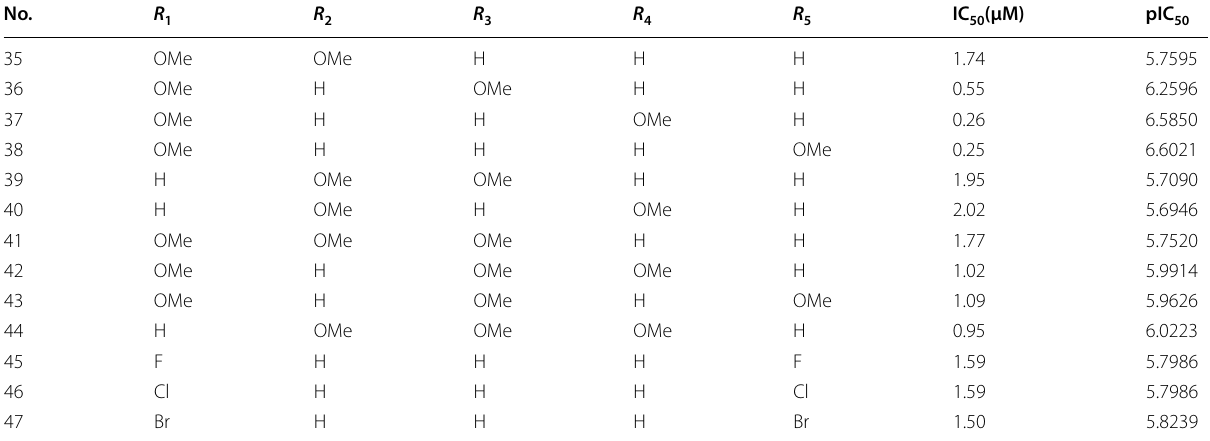
Table 3 The inhibitory activity of parthenolide derivatives for template molecule 3